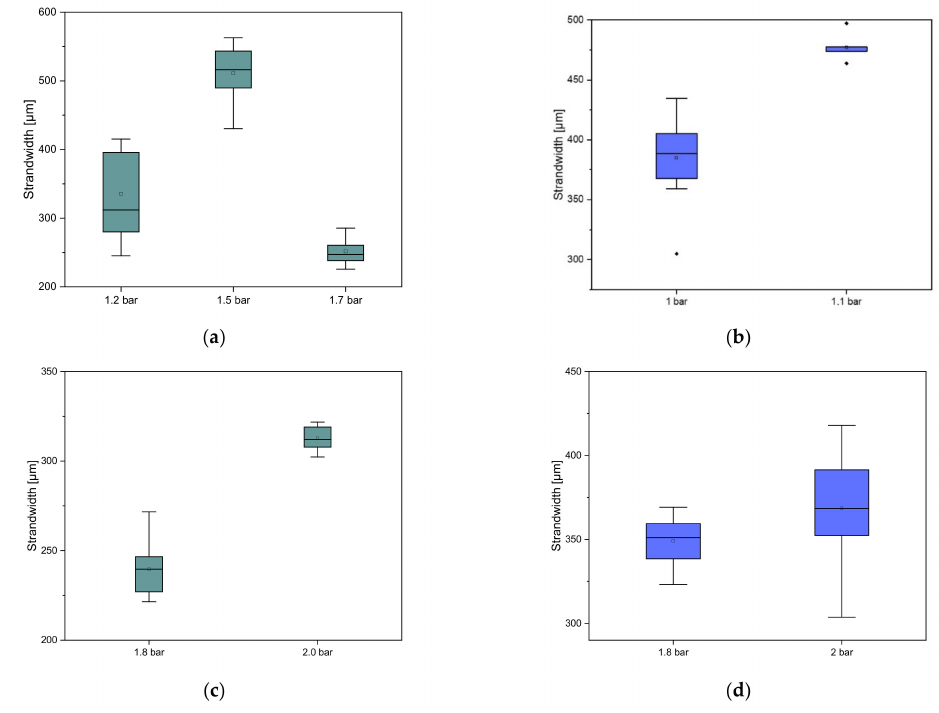
Figure 2. Effects of varying the pressure on the strand width of the scaffolds for ( a ) 250 µ m straight spokes; ( b ) 250 µ m wavy spokes; ( c ) 200 µ m straight spokes; and ( d ) 200 µ m wavy spokes. n =